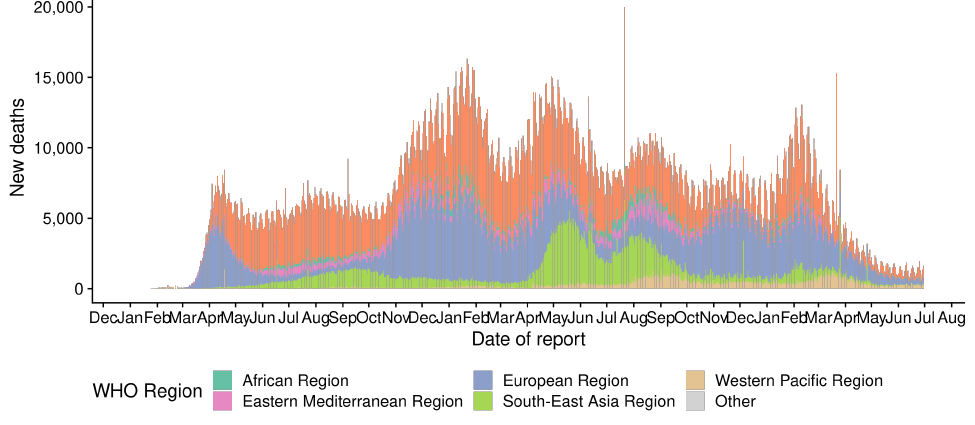
Figure 1. Recent number of confirmed cases in different regions around the world, from the date of report until 2 July